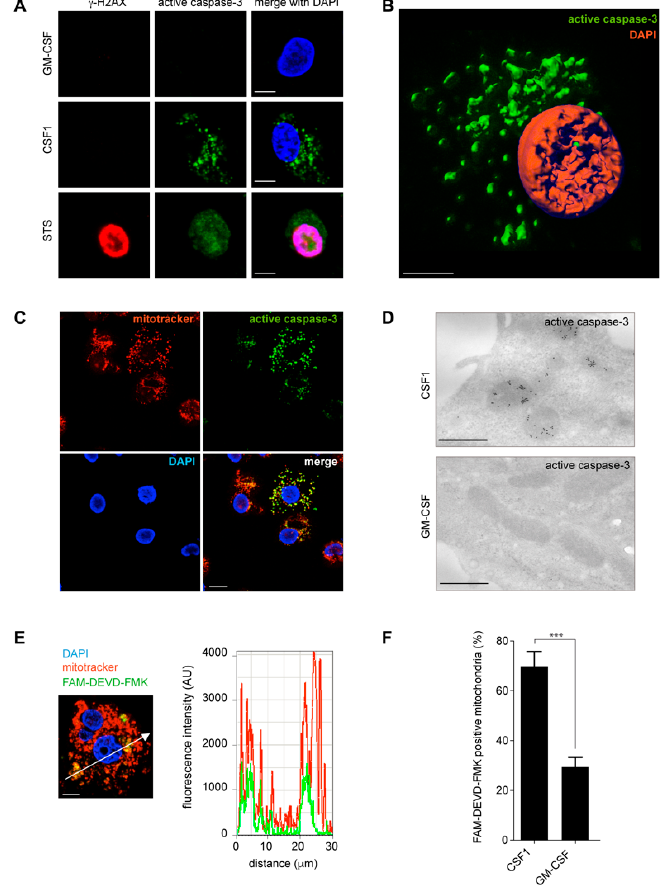
Figure 2. Active caspase-3 and caspase-7 are located to the mitochondria in CSF-1 treated human monocytes ( A ) Active caspase-3 (green), γ -H2AX (red) and DAPI (blue) staining of peripheral blood human monocytes treated with GM-CSF (100 ng/mL, 4 days) or CSF-1 (100 ng/mL, 4 days) or staurosporine (STS, 1 µ M, 3 h). Scale bar, 5 µ m. ( B ) 3D single-cell analysis of active caspase-3 (green) in CSF-1-treated monocyte (nucleus in red, DAPI staining). Scale bar, 5 µ m. ( C ) Active caspase-3 (green), mitochondria (mitotracker, red) and nucleus (DAPI, blue) staining in CSF-1-treated monocytes. Scale bar, 10 µ m. Threshold set to 300 (green) and 800 (red) for co-localization analyses with ImageJ- JACoP; Manders coefficient: 0.812 (fraction of active caspase-3 co-localized with mitochondria). ( D ) Immunogold staining of active caspase-3 in CSF-1- and GM-CSF-treated monocytes showing the co-localization of mitochondria and active caspase-3 in CSF-1-treated monocytes. Scale bar, 0.5 µ m. ( E ) Confocal microscopy image (left panel) and intensity tracing (right panel) of FAM-DEVD- FMK (green) and mitotracker (red) distribution in a CSF-1-treated monocyte (DAPI staining of the nucleus in blue). Scale bar, 5 µ m. ( F ) FAM-DEVD-FMK intensity measured by flow cytometry in tetramethylrhodamine (TMRM) positive mitochondria isolated from CSF-1 and GM-CSF-treated human monocytes (***, p < 0.001; Fisher Exact Test). Mean ±